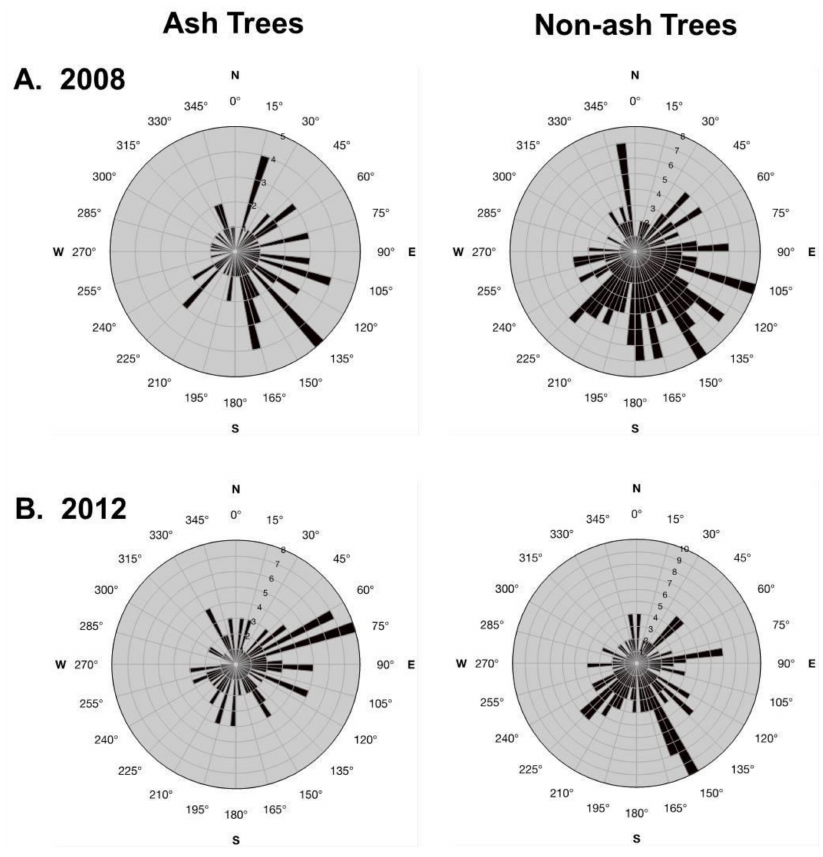
Figure 3. Average azimuth (angles) of the direction of fall for ash (left) and non-ash (right) trees in 2008 ( A ) and 2012 ( B ) in 16 forest stands in the Upper Huron River watershed in southeastern Michigan, USA. The numbers within the circles refer to frequency distribution of the angles of individual trees. Analyses were performed at the transect-level with transects that had <3 fallen trees excluded (2008: N (transects) = 8 for ash and N = 12 for non-ash; 2012: N = 12 for ash and N = 12 for non-ash